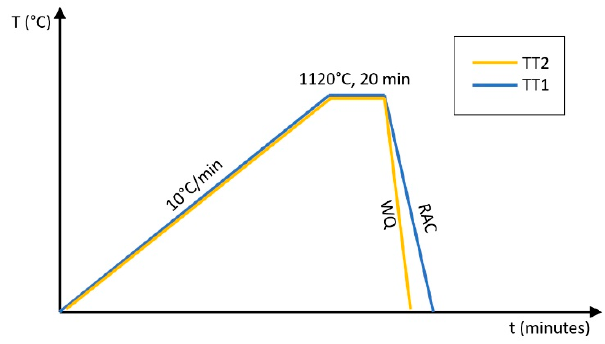
Figure 8. Thermal treatments applied to the specimens.